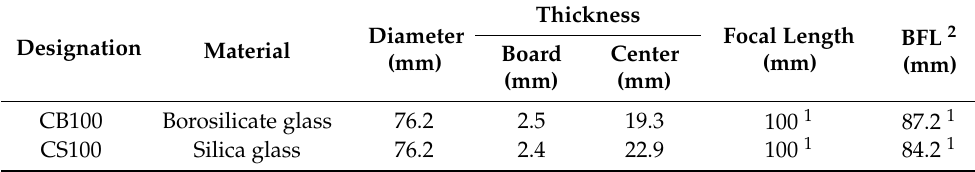
Table 2. Converging lenses (plano-convex) tested in this